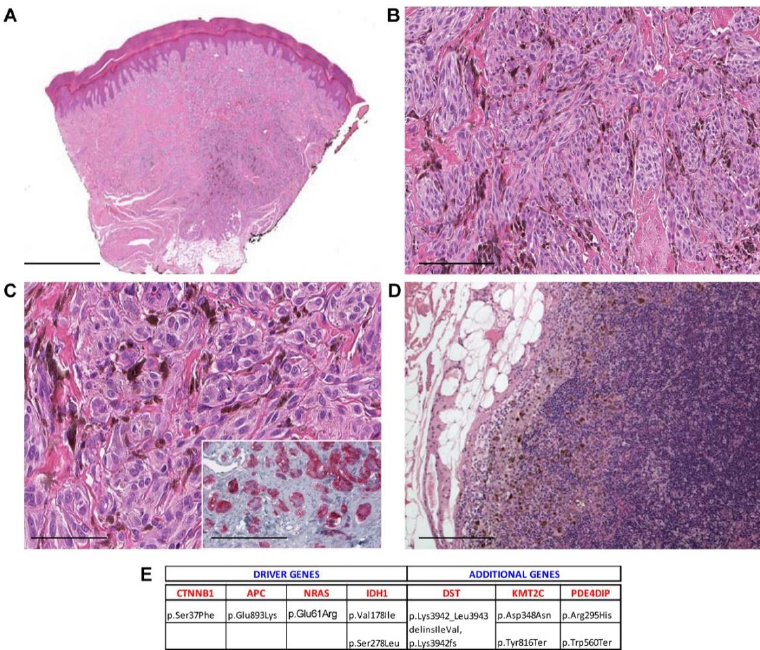
Figure 5. Case 17—female, 43 years old, second interdigital space, right hand. ( A ) Asymmetric melanocytic tumor involving the dermis and subcutis (40×, scale bar 500 µm); ( B ) the tumor is composed of pigmented spindle and ovoid cells in a plexiform growth pattern (200×, scale bar 100 µm); ( C ) melanocytes contain fine melanin granules, and melanophages are admixed (400×, scale bar 50 µm). Inset: Immunostaining for β-catenin shows that melanocytes retain nuclear expression for this marker (400×, scale bar 25 µm). ( D ) Representative image of hematoxylin and eosin (H&E) staining of the positive right axillary sentinel lymph node; subsequent lymphadenectomy showed an additional positive axillary lymph node (200 × , scale bar 50 µ m). ( E ) Mutational profile: driver gene